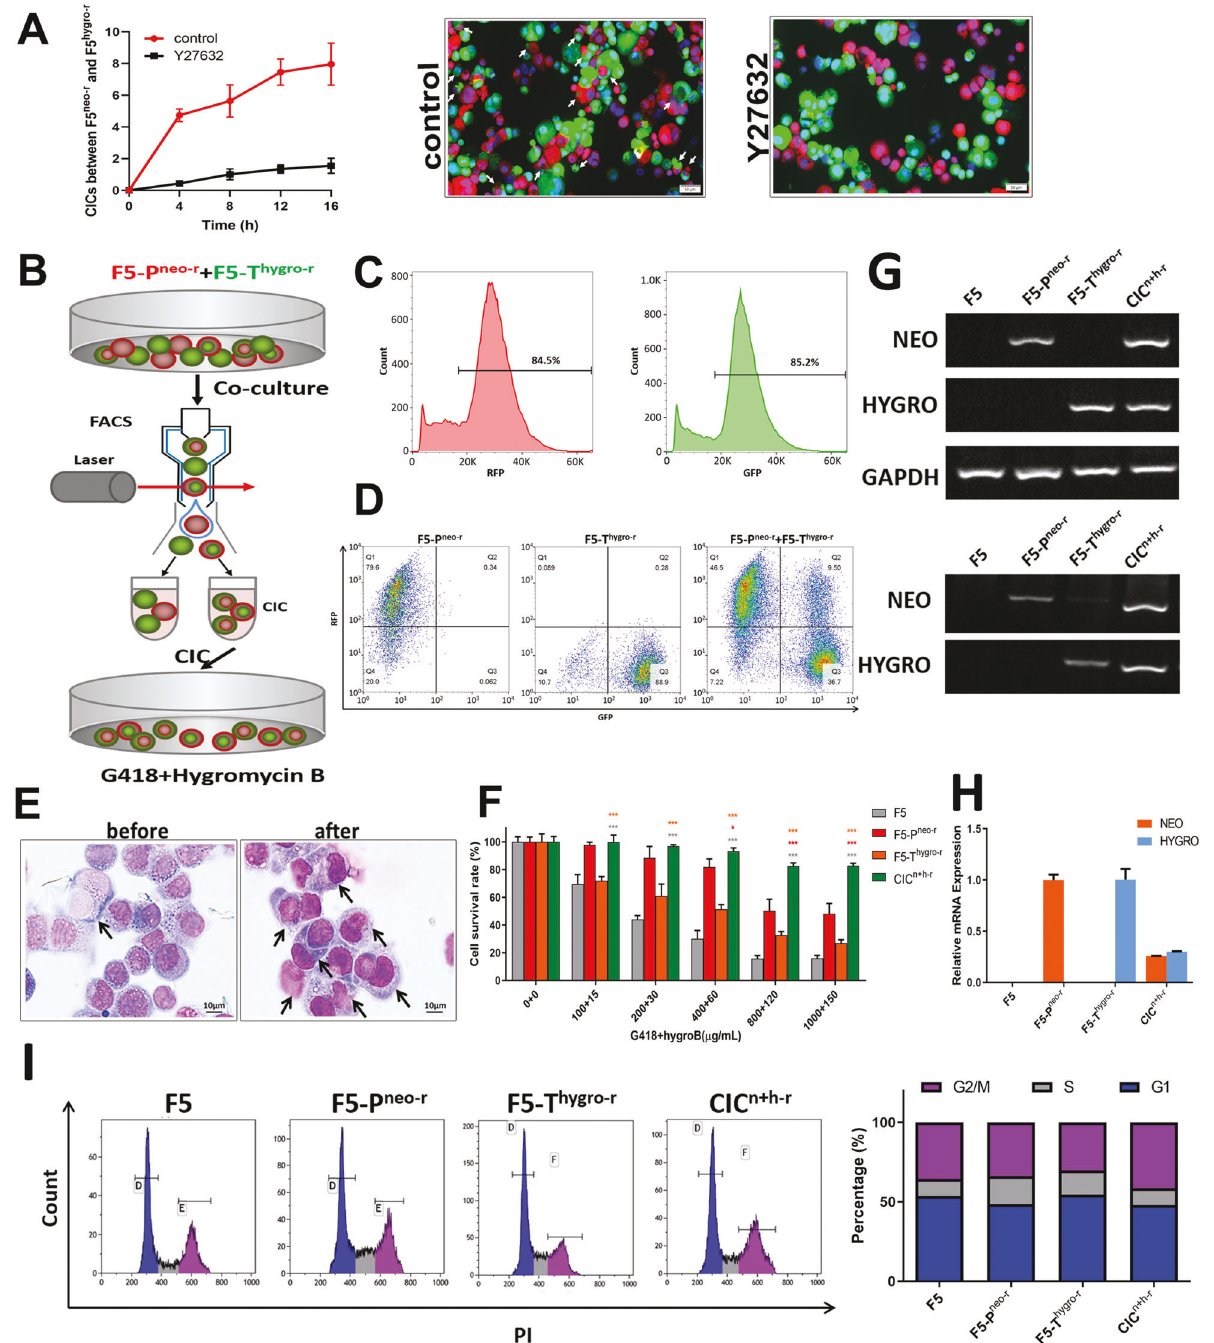
Fig. 2 Evidence for genetic information transferred from both parental cells by cell-in-cell process. A CICs formation between F5 neo-r cells and F5 hygro-r for indicated time in medium with or without Y27632. B Schematic diagram of cell-in-cell process from F5-P neo-r and F5-T hygro-r by FACS assay. C Detecting the RFP or GFP fl uorescence signal of F5-P neo-r and F5-T hygro-r cells by Flow cytometry. D Enrichment of CICs formed between F5-P neo-r and F5-T hygro-r cells by Flow cytometry. E Representative images of F5-P neo-r and F5-T hygro-r cell populations before and after sorting by fl ow cytometry staining with Giemsa. F Detecting cell survival rate of F5, F5-P neo-r , F5-T hygro-r , CIC n + h-r cells in different concentration of G418 and hygro B in combination. G Detecting antibiotic resistance markers (NEO or HYGRO) and GAPDH from RNAs (upper panel) or DNAs (lower panel) extracted from F5, F5-P neo-r , F5-T hygro-r and CIC n + h-r cells by PCR. H The expression of NEO or HYGRO genes of F5, F5-P neo-r , F5-T hygro-r and CIC n + h-r cells detected using qRT-PCR. I Flow cytometric analysis of F5, F5-P neo-r , F5-T hygro-r , CIC n + h-r cells for DNA content by propidium iodide (PI) Analysis of differentially expressed (DE) genes by the cutoff of fold pro fi les were analyzed by RNA-seq. Principle component analysis changes ≥ 2 and p ≤ 0.05 identi fi ed 102 genes, with 59 (PCA) showed that the two CICs clones tightly clustered with each upregulated and 43 downregulated, respectively, between CICs other, which showed striking difference to their original parental clones and their parental cells (Table S2). The result was visualized cell F5, followed sequentially by F5-P neo-r and F5-T hygro-r (Fig. 6A).